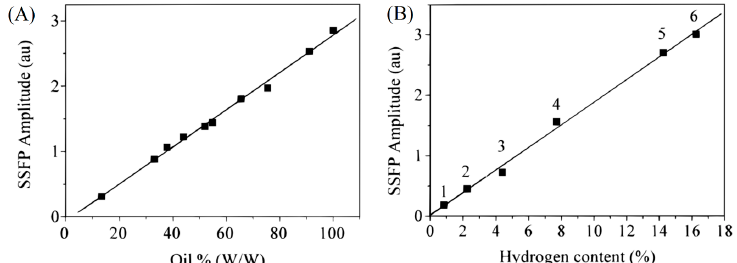
Figure 5. ( A ) Magnitude of CWFP signal in arbitrary unit (au) as a function of oil concentration of the sunflower oil dissolved in carbon tetrachloride, r = 0.997. ( B ) Magnitude of CWFP signal as a function of hydrogen content in various solvents: (1) chloroform, (2) 1,1,1 trichloroethane, (3) 1,2 dichloroethane, (4) benzene, (5) cyclohexane, and (6) hexane; r = 0.998. Adapted from Publication [12], Copyright (2000), with permission from ACS Publications.